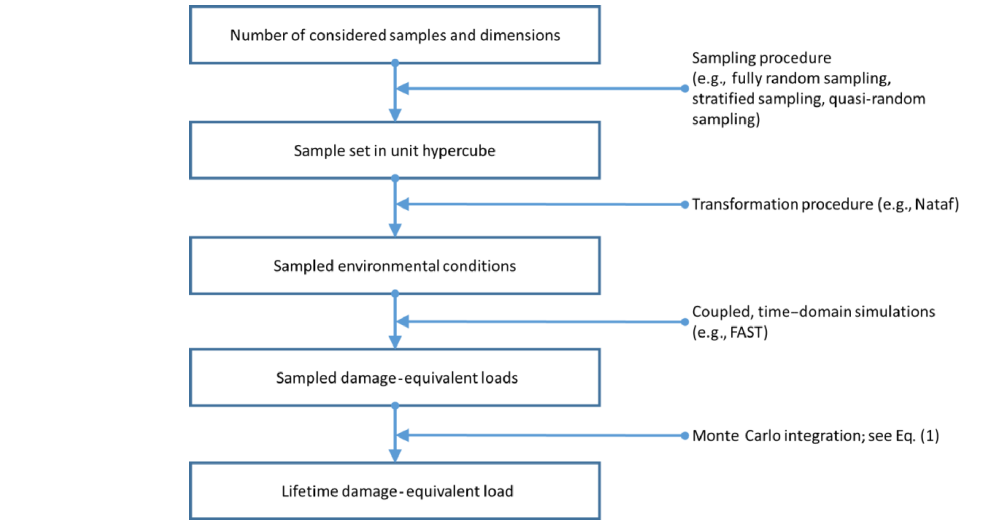
Figure 1. Workflow for FOWT damage assessment via sampling techniques.